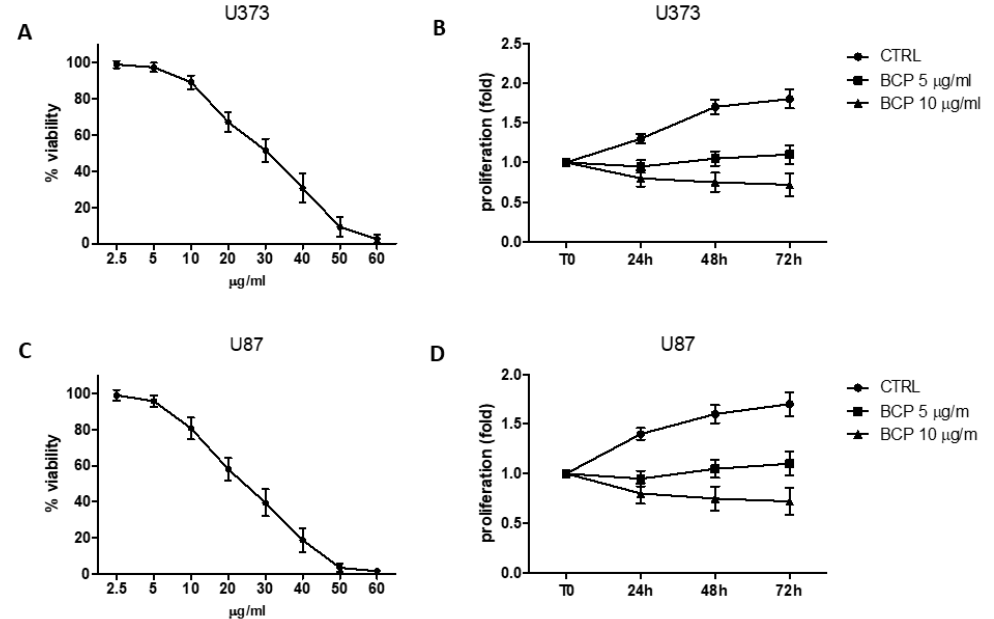
Figure 1. Dose response curve of cell viability assessed in U373 (panel A ) and U87 (panel C ) cells treated with b-caryophyllene (BCP). Values are expressed as percentage of reduction of viability with respect to the untreated control. Cell proliferation evaluation at T0, 24, 48 and 72 h in U373 (panel B ) and U87 (panel D ) cells treated with BCP. Values are expressed as fold change of viability with respect to the untreated control at T0.